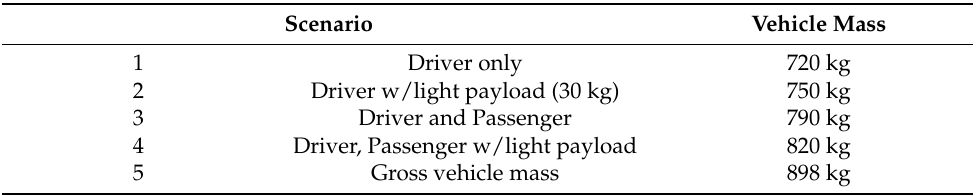
Table 5. Vehicle masses considered in the tuning operation.